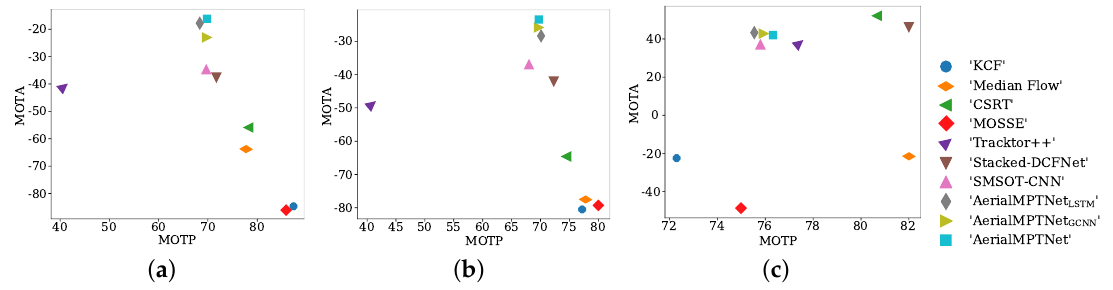
Figure 23. Ranking the tracking methods based on their MOTA and MOTP values on the ( a ) KIT AIS pedestrian, ( b ) AerialMPT, and ( c ) KIT AIS vehicle